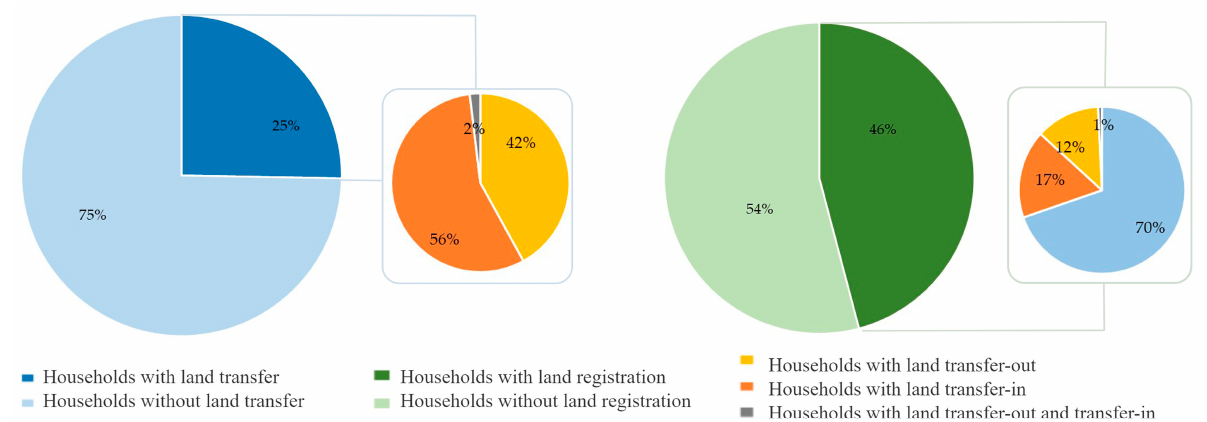
Figure 5. Land registration proportion in various provinces in rural China.